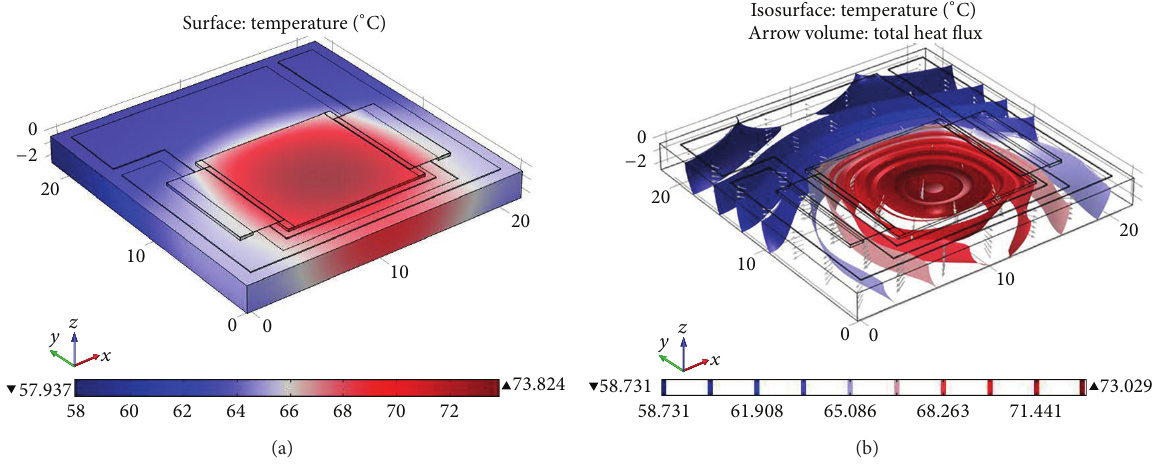
Figure 6: Temperature distribution (a) and isothermal contours (b) in the IMS based assembly, in ∘ C. Max cell’s temperature: 73.8 ∘